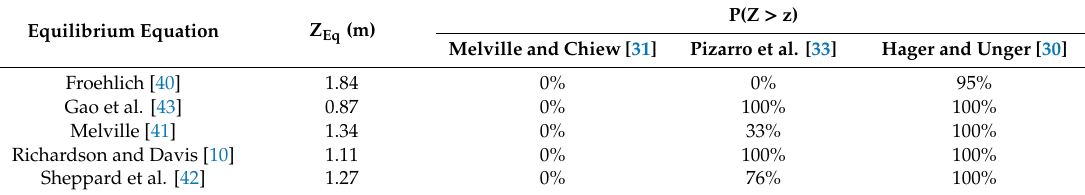
Table 4. Benchmarking of di ff erent scour models in terms of the exceedance probability of z. T = 100 years, k = 2, and PTP =